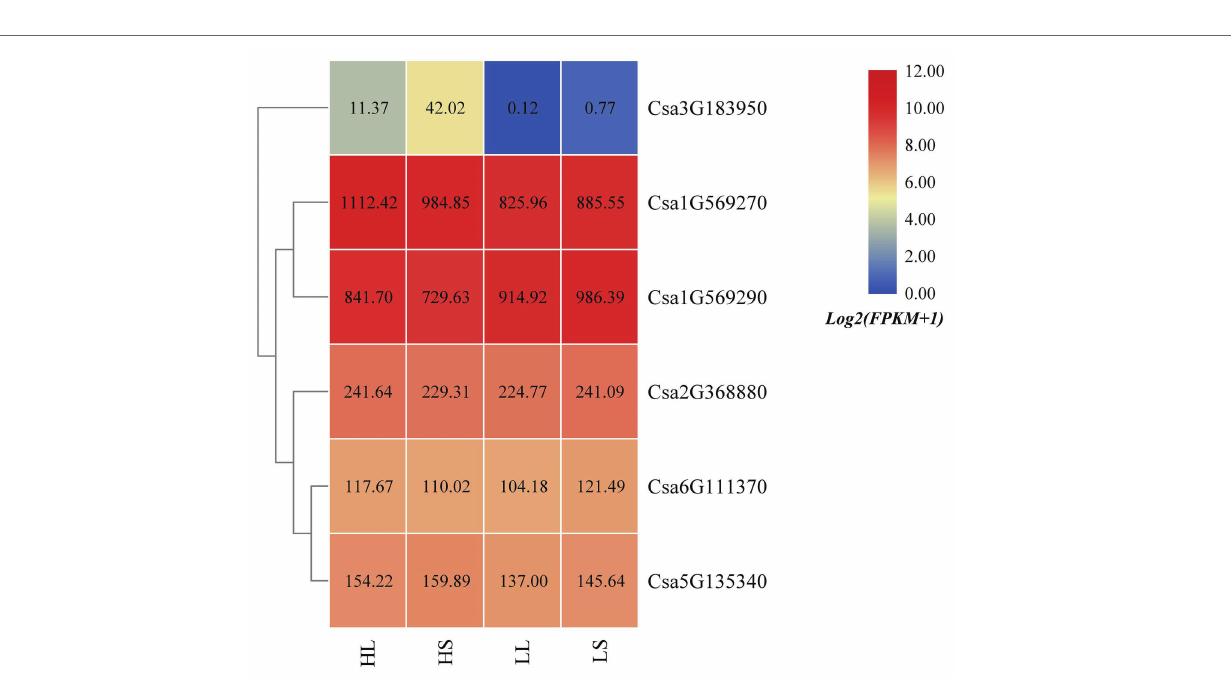
FIGURE 6 | Relative expression levels of six cucumber HSP90 gene after 0, 3, 6, and 12 h treatment of heat stress in cucumber seedlings by qRT-PCR analysis. Data are displayed using the CsActin gene as an internal control with three biological and three technical replicates. Values are the mean ± SD.